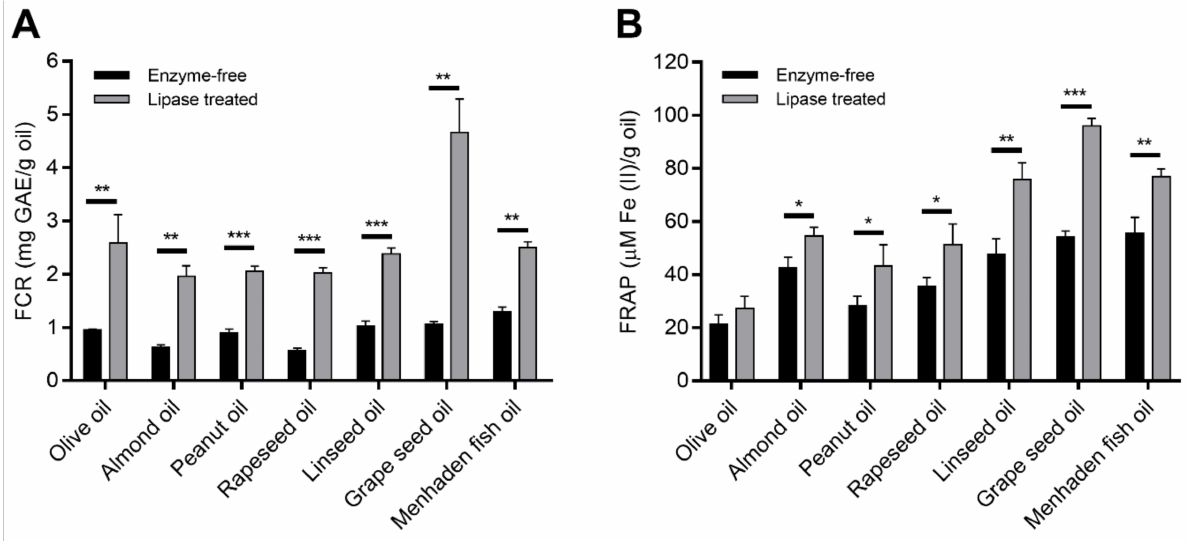
Figure 2. Comparison of FCR ( A ) and FRAP activity ( B ) of enzyme-free and R. miehei lipase-treated olive, almond, peanut, rapeseed, linseed, grape seed and menhaden fish oil samples. Results are means of data of three replicates; error bars represent standard deviations. Asterisks indicate significant difference between the enzyme-free and treated samples according to a multiple t -test performed in GraphPad Prism version 7.00, FDR (Q = 10%), * p < 0.05, ** p < 0.01, *** p <